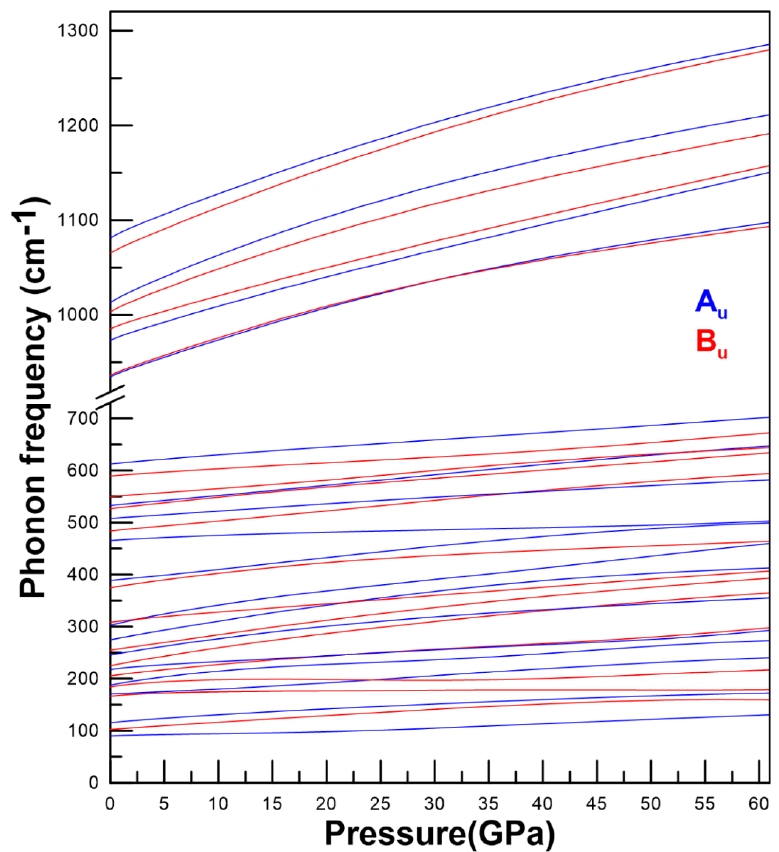
Figure 11. (Color online) Pressure dependence of the infrared modes of monazite-type GdPO 4 . Figure 11. ( Color online ) Pressure dependence of the infrared modes of monazite-type GdPO 4